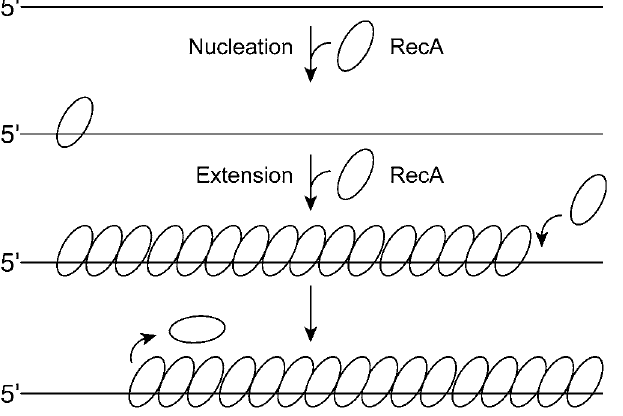
Figure 1. RecA Filament Assembly and Disassembly on ssDNA The reaction is limited by a slow nucleation step, followed by rapid extension in the 5 9 to 3 9 direction. Disassembly is also uniquely 5 9 to 3 9 , proceeding from the end opposite to that where extension occurs. Dissociation of RecA monomers at the disassembling end requires ATP hydrolysis (see text). DOI: